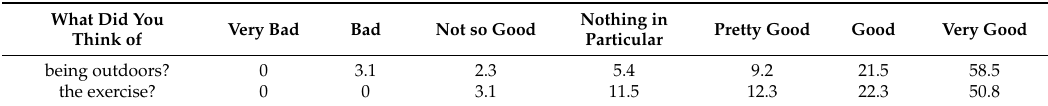
Table 2. Opinions on being outdoors and exercise. n =